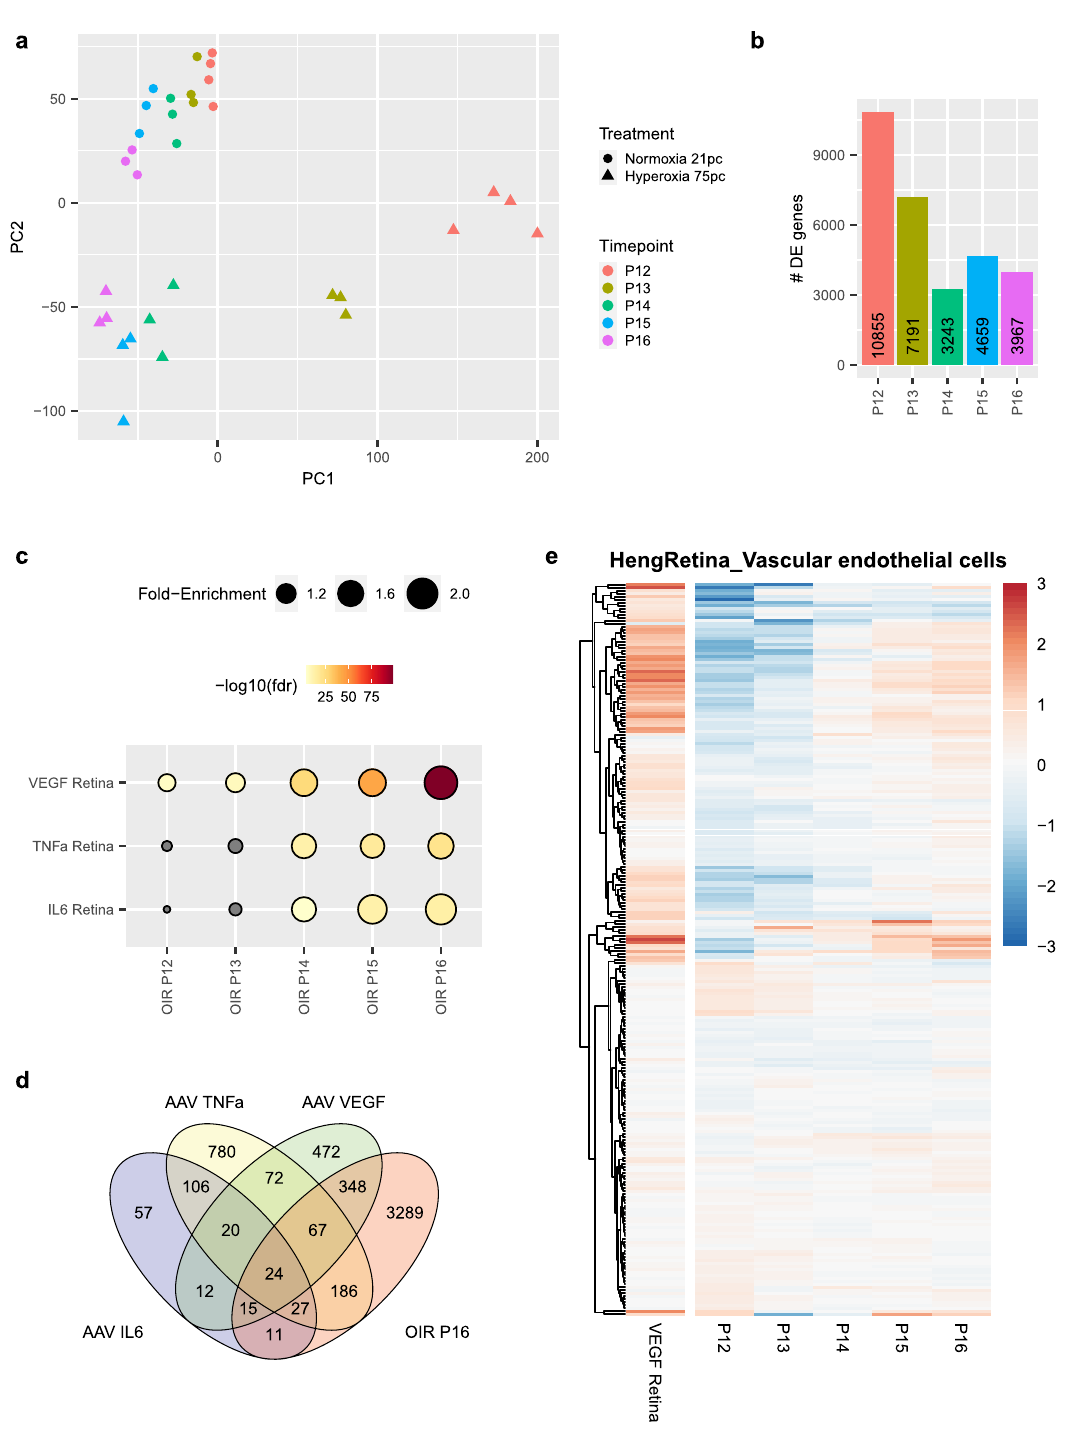
Figure 7. Transcriptomic signature of AAV-VEGF treatment is most similar to that observed in P16 OIR mice. ( a ) PCA demonstrated a clear separation of samples according to treatment (normoxia vs. hypoxia) and timepoint. ( b ) The largest number of gene expression changes was observed at P12 and P13 and the number of differentially regulated genes stabilized at 3000–5000 genes at P14-P16. ( c ) The strongest enrichment for similar gene expression pattern was observed between OIR P16 and AAV-VEGF (2.2 fold-enrichment). ( d ) Overlap between DE genes of AAV-VEGF, AAV-TNF-α, AAV-IL6 and the OIR model (P16) are depicted in the Venn diagram. ( e ) Genes specifically expressed by endothelial cells were upregulated in AAV-VEGF injected eyes and P15/P16 OIR retina, but not P12/P13 OIR